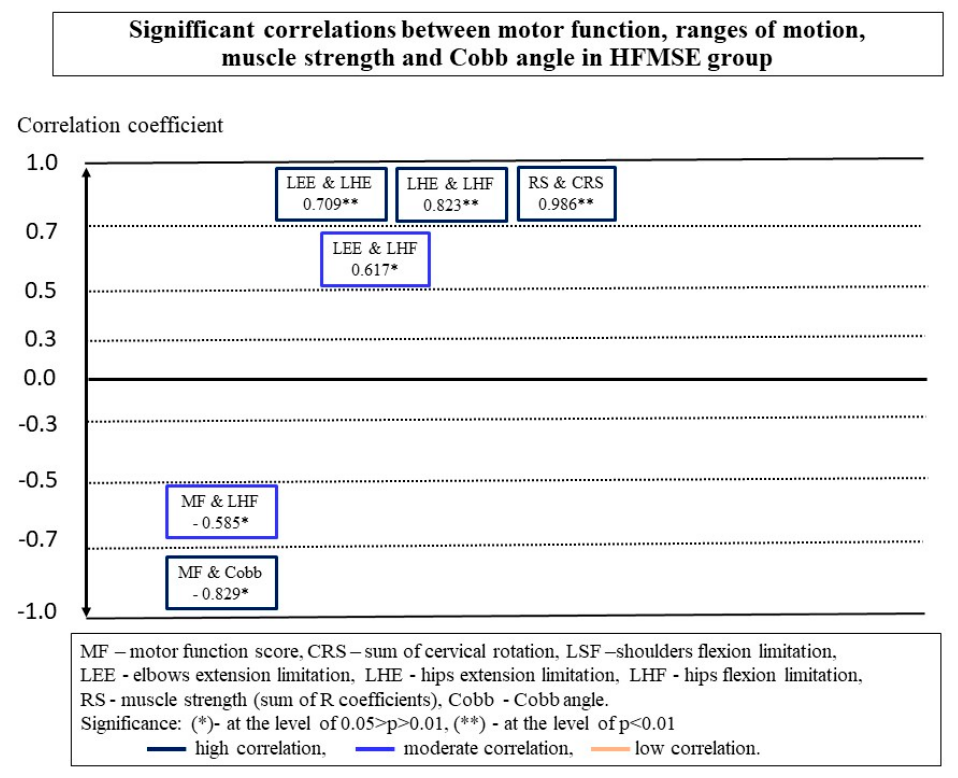
Figure 3. Significant correlations between motor function, range of motion, muscle strength, and Cobb angle in the HFMSE